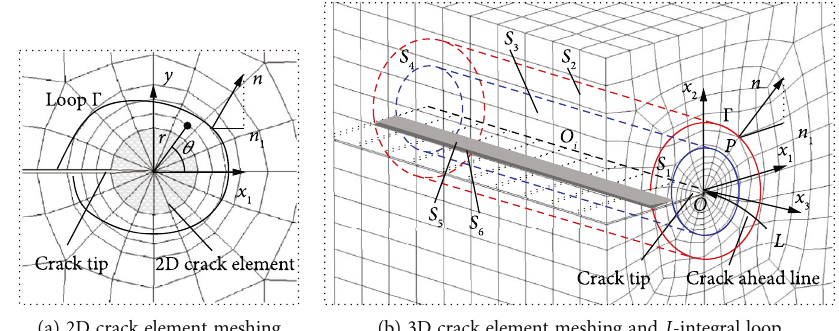
Figure 2: 2D and 3D crack element meshing and J -integral